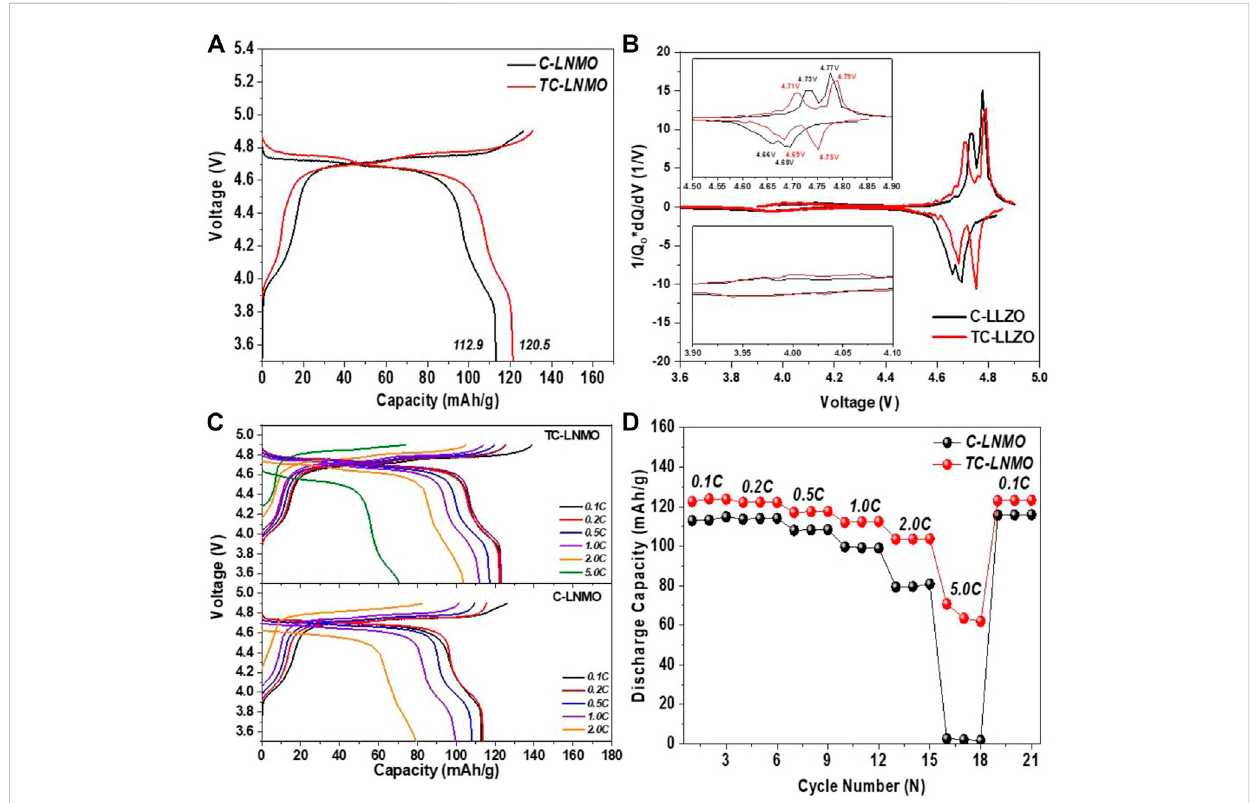
Electrochemical evaluation results of C-LNMO and T-cLNMO measured in the voltage range of 3.5 – 4.9 V at 0.1 ° C current density at 25 ° C: (A) Initial charge/discharge curves. (B) dQ/dV curves corresponding to the initial voltage pro fi le. (C) Galvanostatic discharge curves at different C-rates. (D) Rate capability from 0.1 ° C to 5 C.